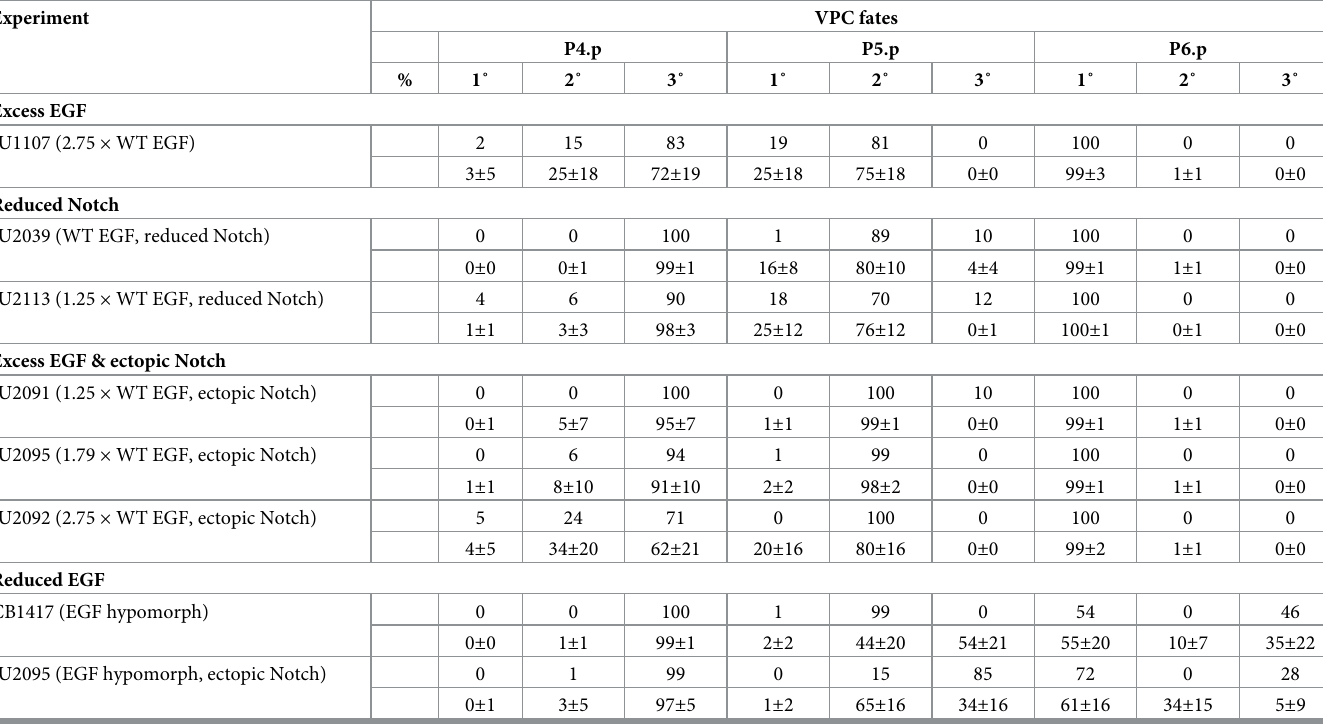
For each mutant, the experimental percentages (top) and simulated percentages (mean ± SD, bottom) for each VPC becoming each fate are shown. In the experimental data, fates for P4.p and P8.p (or P5.p and P7.p) have been averaged, since we assume that the pattern is symmetrical around the anchor